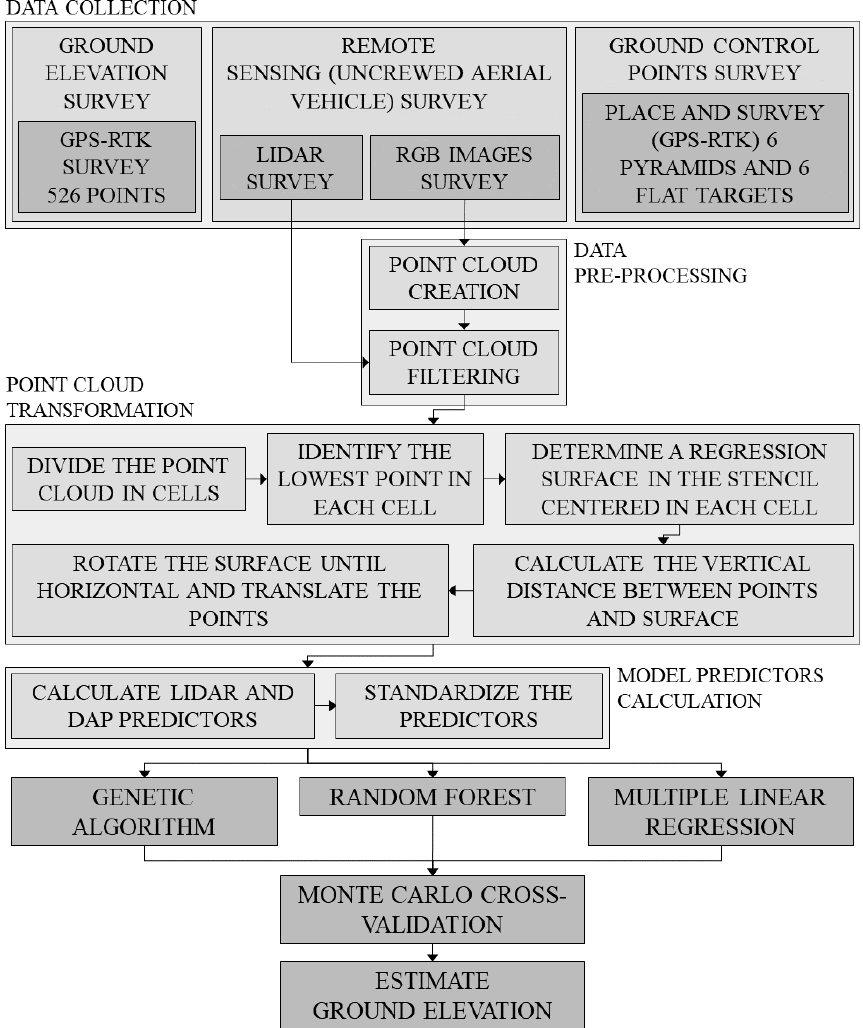
Figure 1. Flow chart describing the procedure used in this study to evaluate the performances of different point clouds and regression techniques on ground elevation estimate.